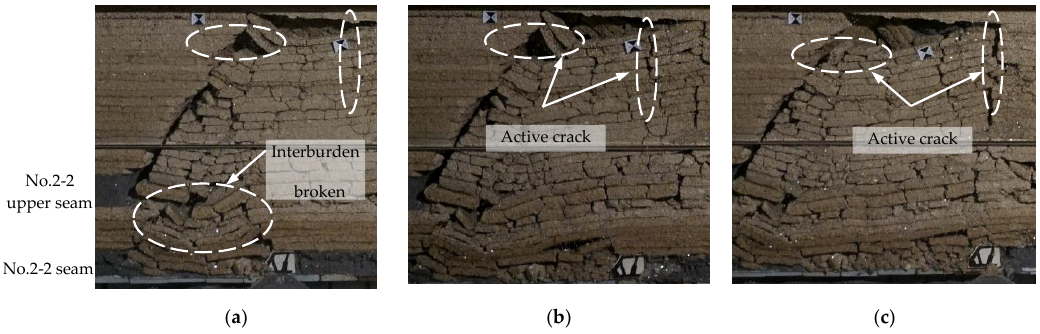
Figure 10. 22104 working face activation cracks development schematic diagram: ( a ) advanced to 20 m, ( b ) advanced to 27.5 m, and ( c ) advanced to 35 m.